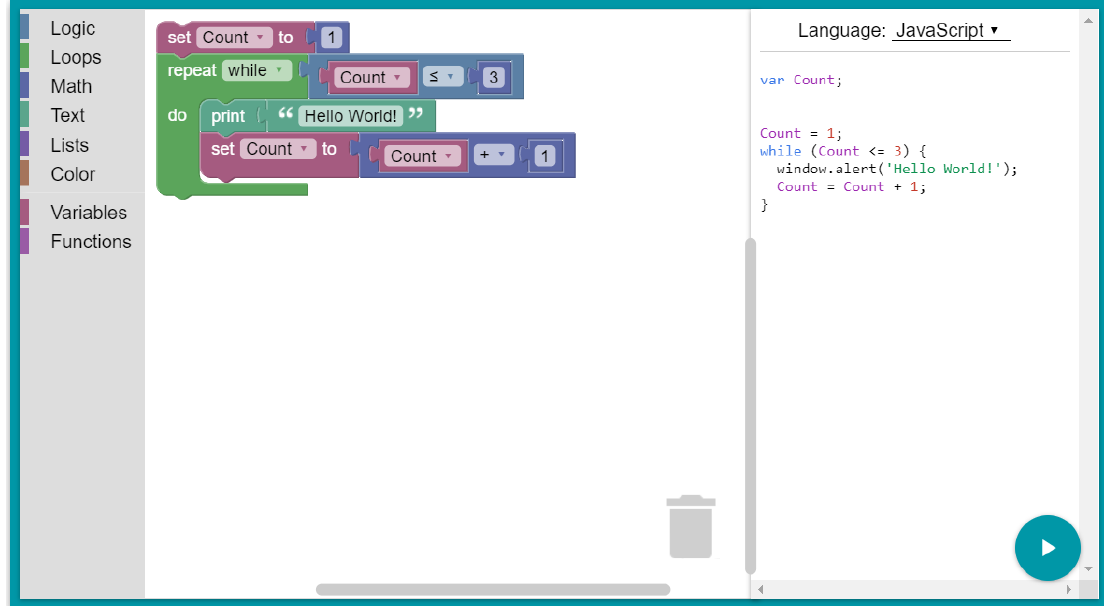
Figure 1. The visual interface of Blockly for generating JavaScript from